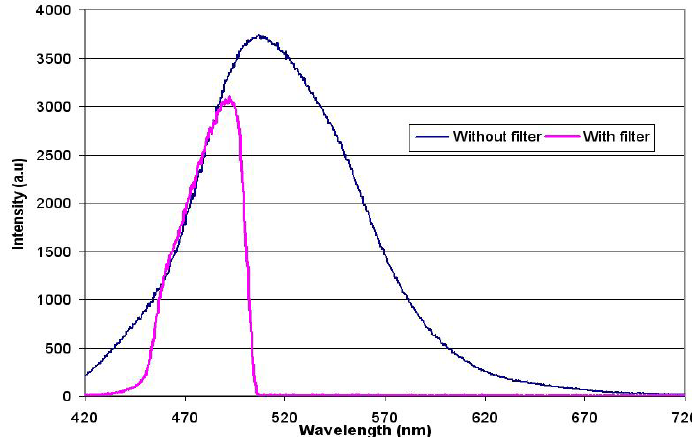
Figure 4. OLED excitation with and without filter.